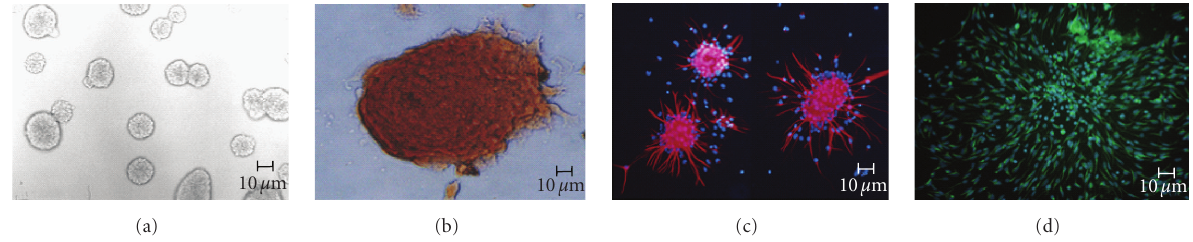
Figure 1: Neural progenitor cell identification and Flt3 expression. (a) Neurospheres under bright field. (b) Flt3-HRP staining on neural spheres. (c) nestin immunofluorescence on neurospheres, RED nestin, BLUE DAPI. (d) Nestin immunofluorescence on single NPC, GREEN nestin, BLUE DAPI.